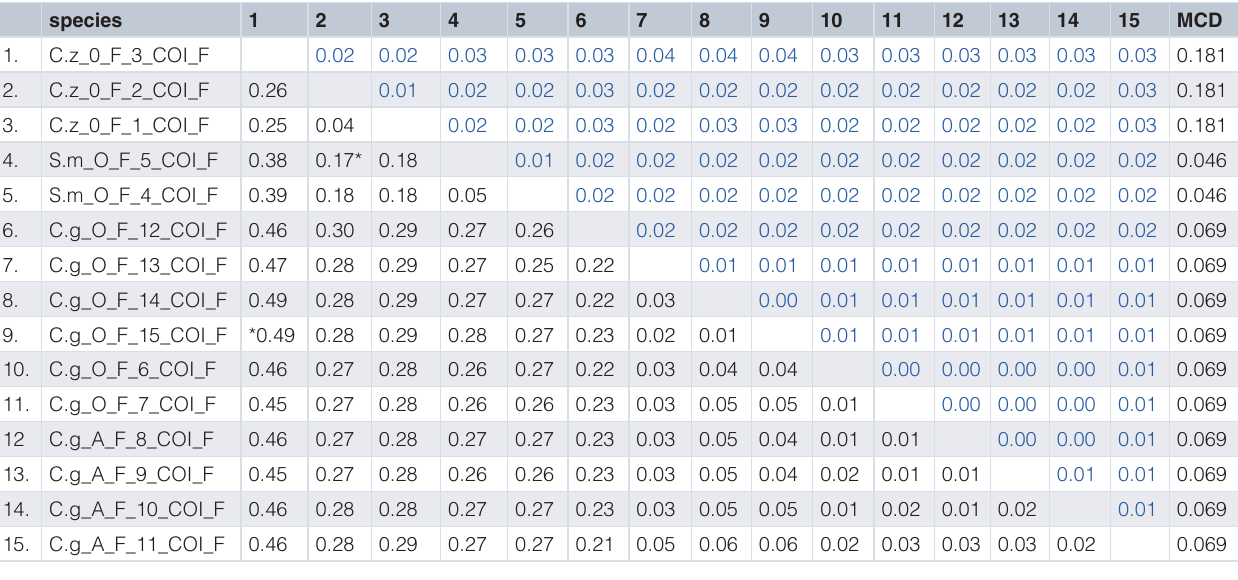
Table 5. COI estimates of pairwise genetic distances between C. gariepinus , C. zillii and S. melanotheron based on Kimura 2-Parameter model. Pairwise conspecific divergence was denoted by the number of base substitutions per site between species (below diagonal) with their corresponding standard error estimate(s) (above the diagonal). Complete deletion of all codon positions (1st, 2nd, 3rd, and Noncoding), were employed in this analysis. All positions. *Genetic distance resulting from intraspecific variation between C. gariepinus - S. melanotheron and C. zillii – S. melanotheron . Mean conspecific divergence, (MCD).